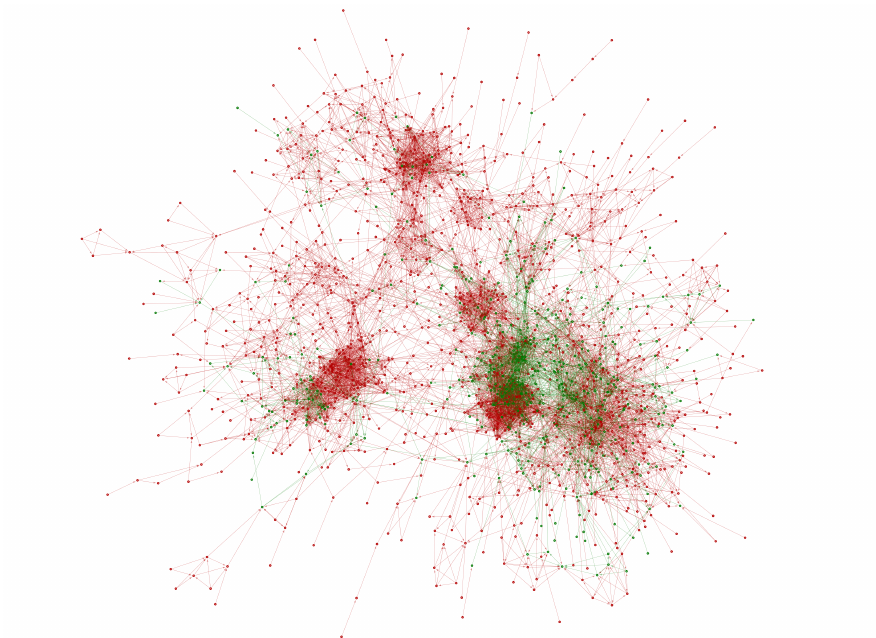
Fig. 3. Our experiments use a DAG structure with 1,421 time-ordered nodes, where green represents the citation relationships of the first 421 nodes, while red represents the citation relationships of the last 1,000 nodes. We consider the state transition { G t } 1000 by letting the green (subgraph) be G 0 t = 0